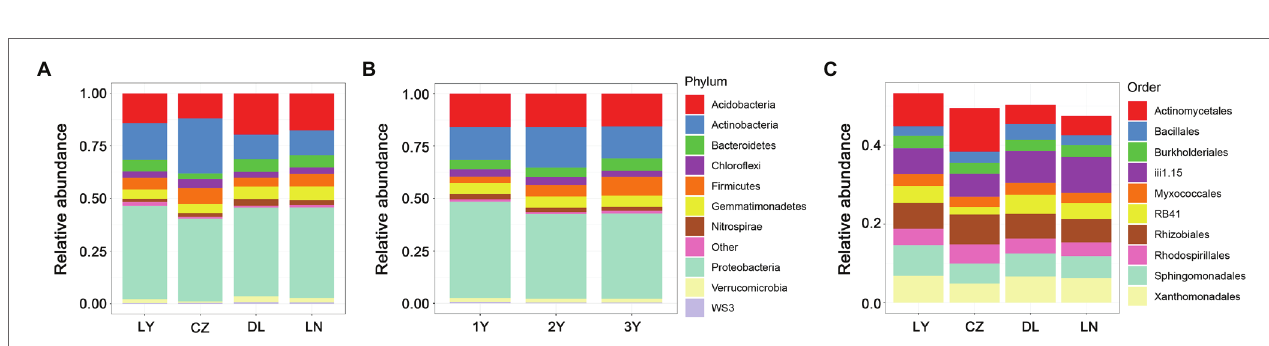
FIGURE 2 | Taxonomic structure of the bacterial communities in the rhizosphere of S. flavescens from different geographic locations (A,C) or of different ages (B) at the phylum (A,B) or order (C) level. LN: Lingyuan; CZ: Changzhi; DL: Dali; LN: Luonan. 1Y: 1-year-old; 2Y: 2-year-old; 3Y: